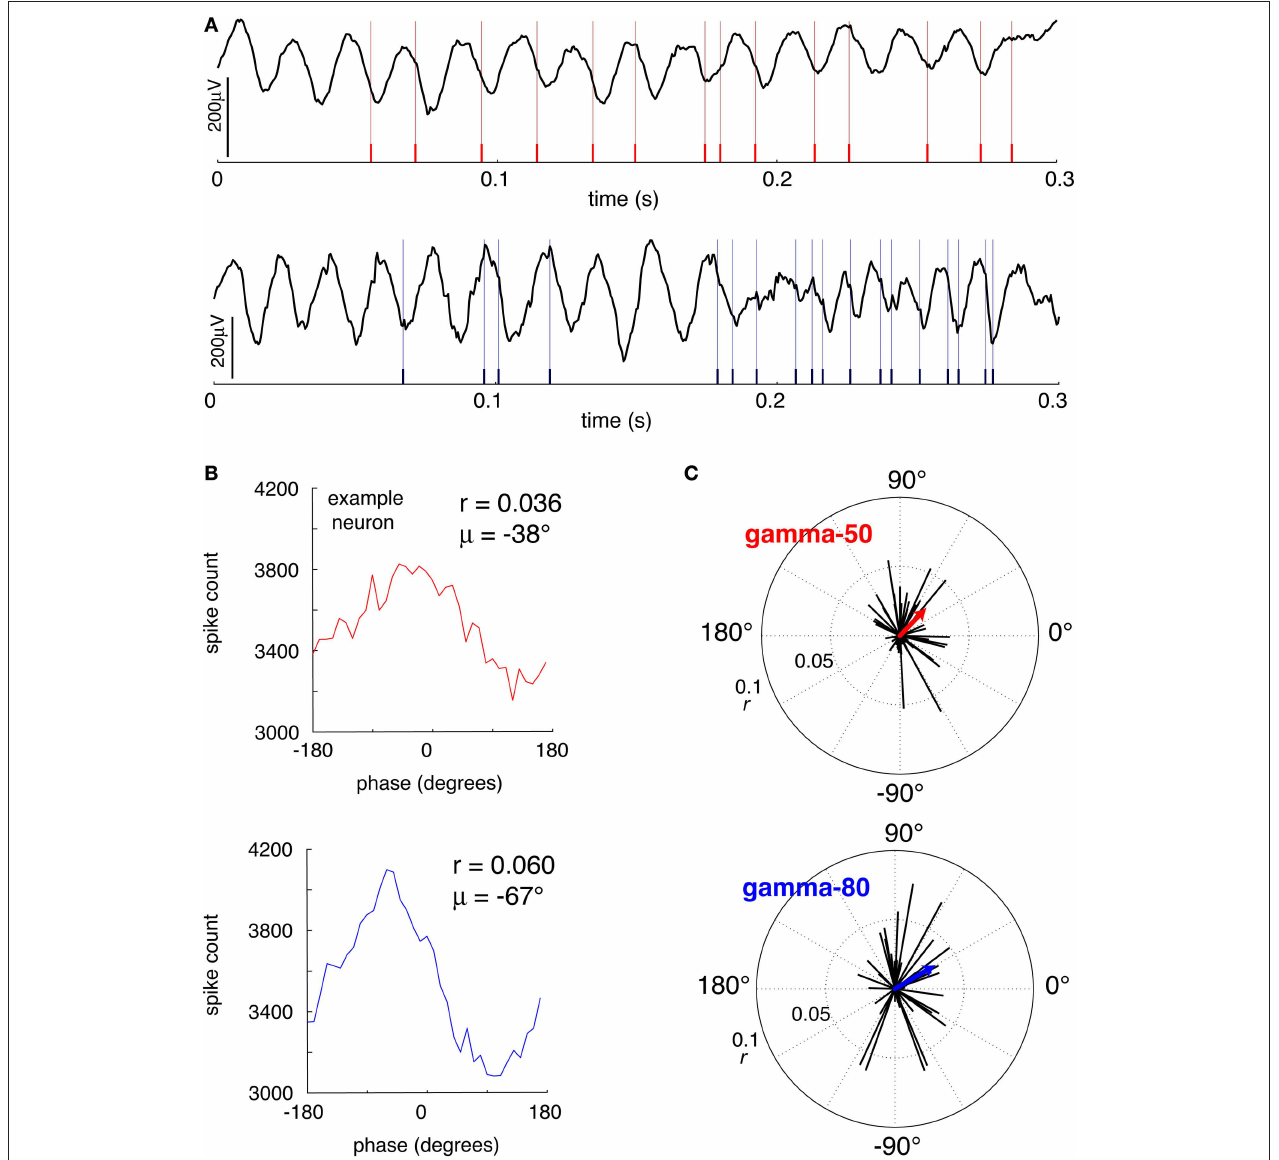
FIGURE 12 | Putative fast-spiking interneurons (FSIs) showed signifi cant gamma phase modulation. (A) Example LFP traces showing episodes of high coherence at 50 Hz (top) and 80 Hz (bottom). (B) Gamma phase histograms at 50 Hz (top) and 80 Hz (bottom) for an example neuron (same neuron as A , top). (C) Polar plots of the phase angle and magnitude for all FSIs at 50 Hz (top) and